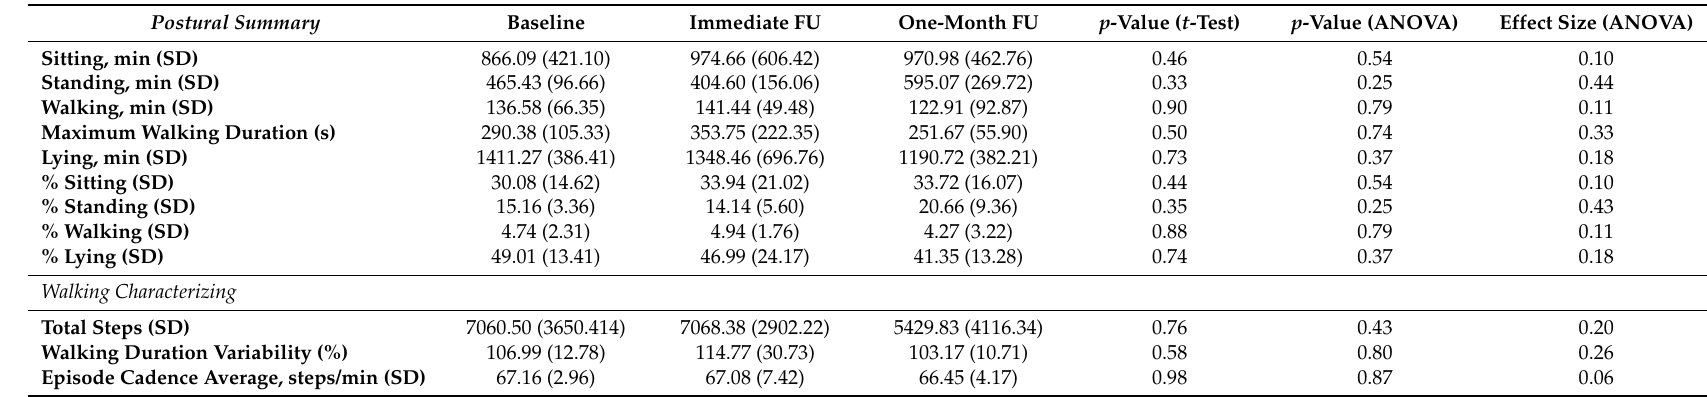
Table 2. Mean (SD: standard deviation) of objective 48 h daily physical activity measurements. p -value for Student’s t -test of baseline and immediate follow-up comparison, p -value for repeated measure ANOVA, and effect size for ANOVA are reported. An asterisk indicates statistical